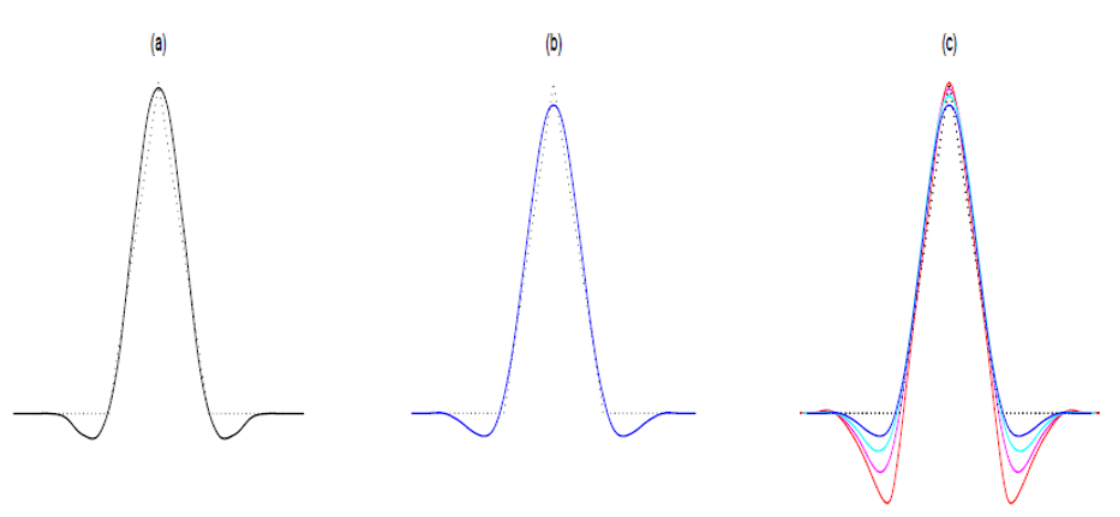
Figure 3. The continuous curves represent the behaviour of the basis function of schemes [12], [13] and proposed scheme (11), taking different values of α , in (a), (b) and (c), respectively, after three subdivision steps and dotted lines are initial control points.